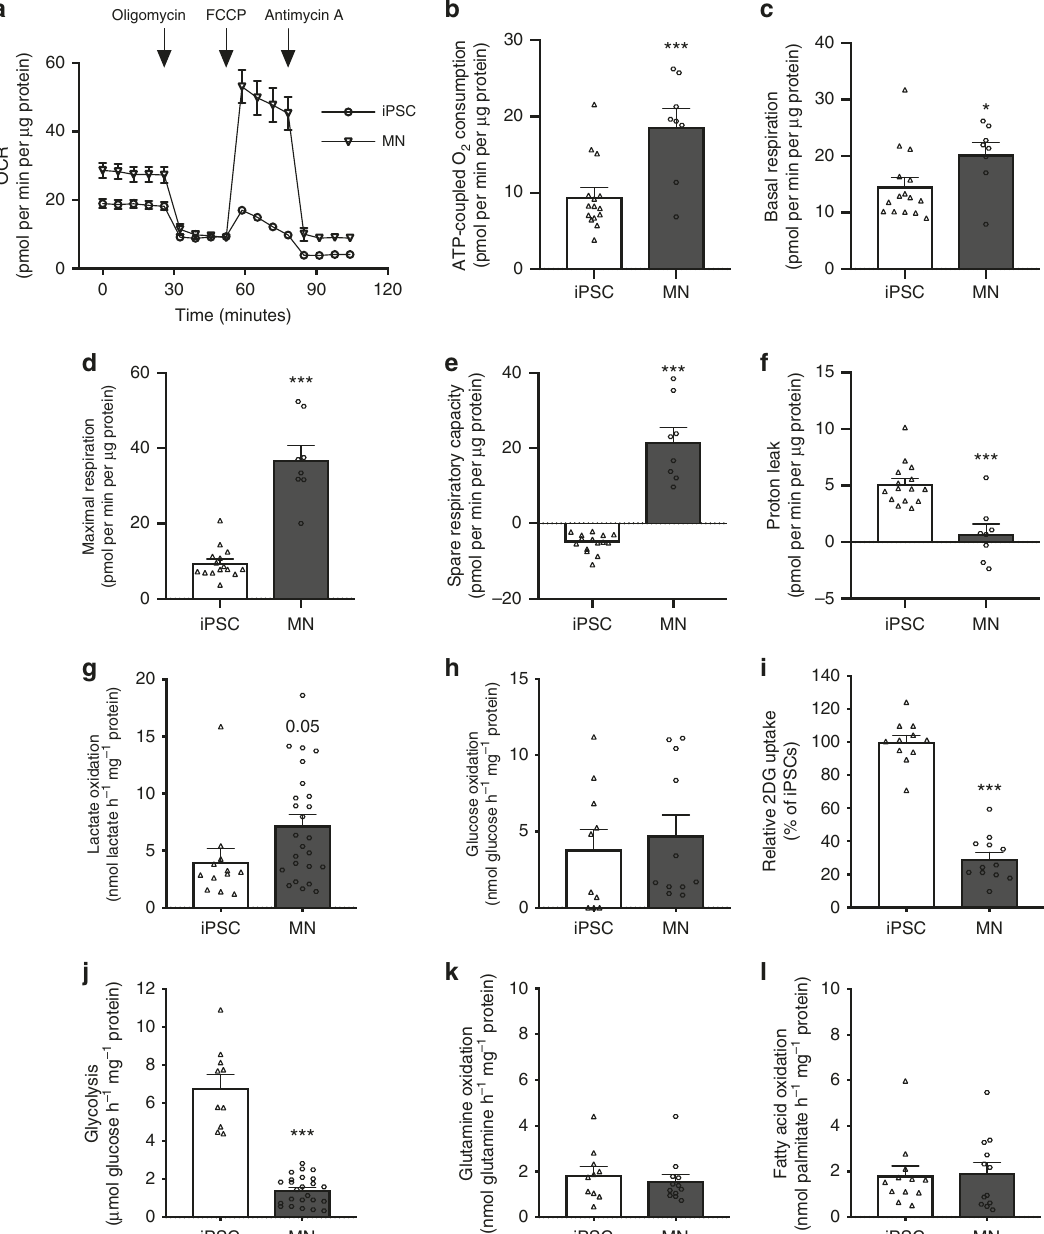
NATURE COMMUNICATIONS| (2019) 10:4147